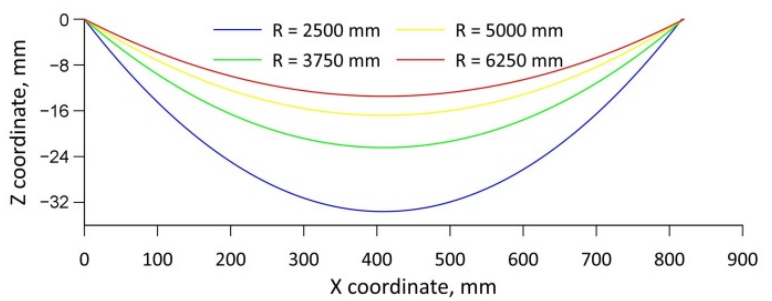
Figure 15. The trajectories of movement of wedge ‐ shaped concave tools.